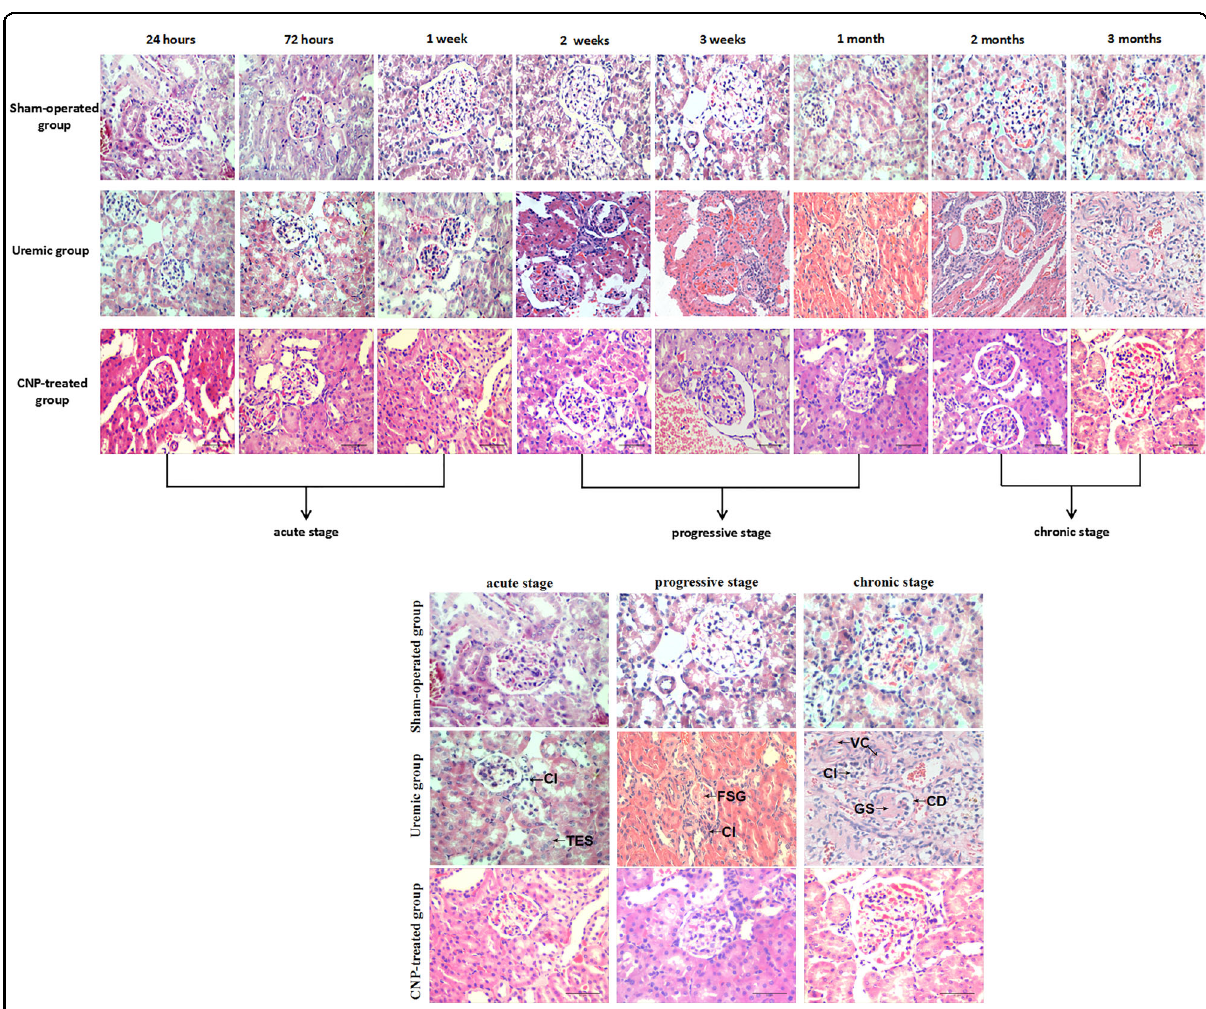
Fig. 2 Representative histological images of kidneys in sham-operated, uremic and CNP-treated rats. Sham-operated group : Sections derived from sham-operated kidneys had a normal appearance. Uremic group : In the acute stage, renal damage was limited to renal tubular epithelial swelling (TES), and interstitial expansion, accompanied by in fl ammatory cell in fi ltration (CI) in both the glomeruli and interstitium; subsequently, the uremic group displayed focal segmental glomerulosclerosis (FSG), in fl ammatory cell in fi ltration (CI), and marked interstitial expansion during the progressive stage; when entering into the chronic stage, renal pathology was characterized by glomerulosclerosis (GS), corpuscle distortion (CD), in fl ammatory cell in fi ltration (CI), and vascular congestion (VC). In contrast, sections derived from sham-operated kidneys had a normal appearance. Therefore, adriamycin injection could induce persistent renal dysfunction and pathological lesions in rats. CNP-treated group: There were no apparent differences in any aspects of renal damage between the CNP-treated group and uremic group in the acute stage. In the progressive stage and chronic stage, the degree of focal segmental glomerulosclerosis (FSG), corpuscle distortion (CD), and interstitial expansion in the uremic group was prominently ameliorated by